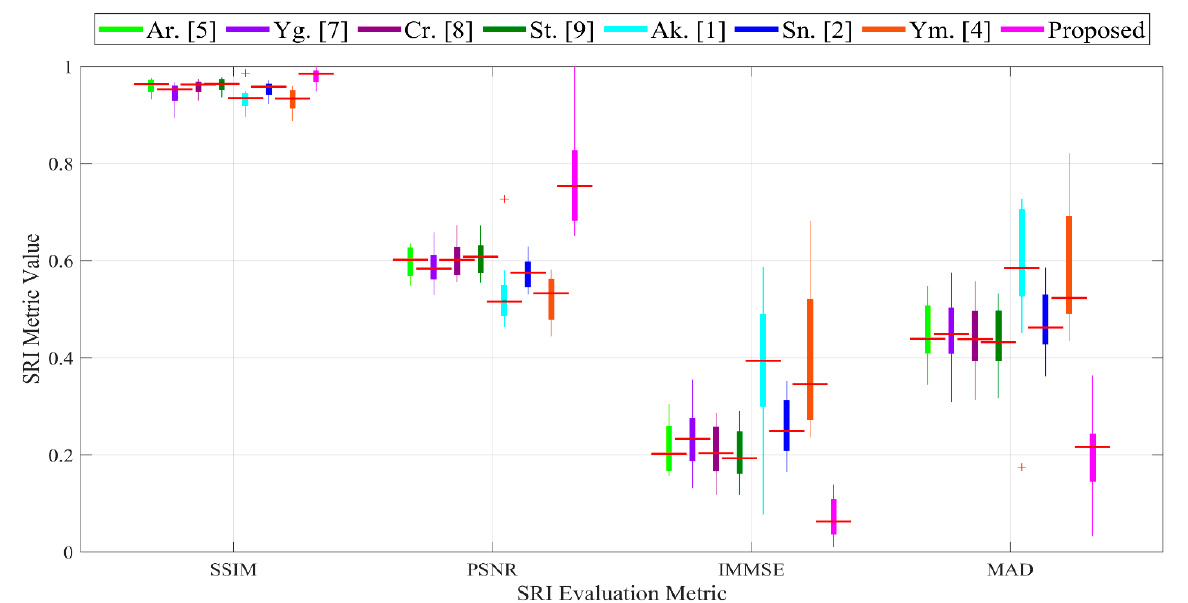
Figure 16. Evaluation results for SRI performances of individual methods for each maiden specular suppressed image of 18 objects in terms of SSIM, PSNR, IMMSE, and MAD.